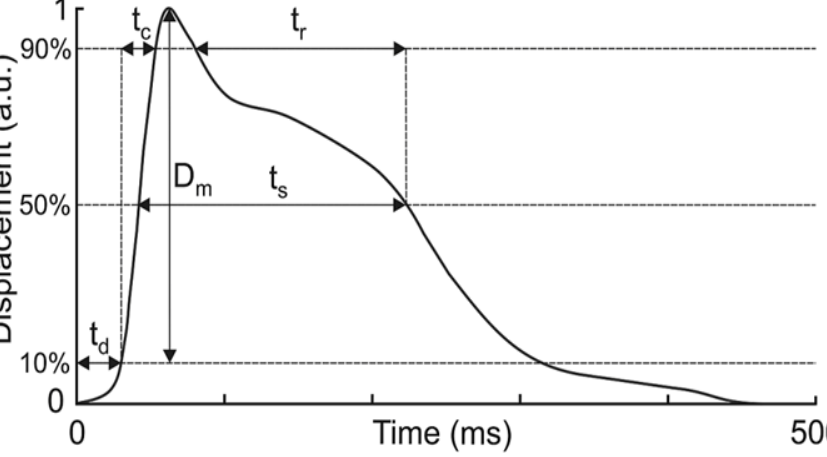
Figure 3. Variables of Tensiomyography measurement (International society of tensiomyography).